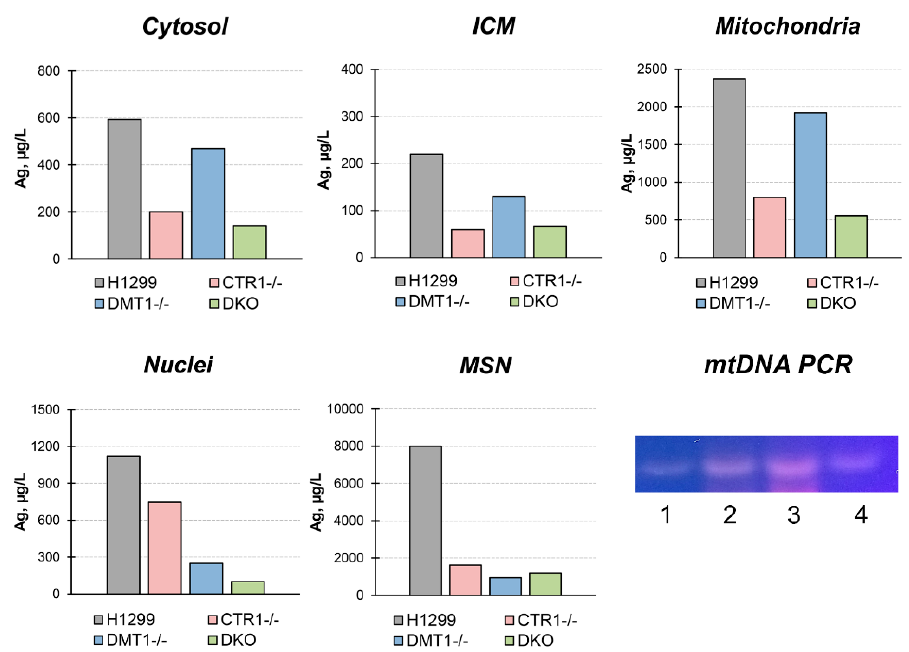
Figure 4. Silver distribution in H1299, CTR1 KO, DMT1 KO, and DKO cells. Y-axis: copper concentration (µg/L) in subcellular fractions. Gel: mtDNA-specific PCR products in subcellular fractions isolated from H1299 cells. 1, nuclei; 2, MSN; 3, mitochondria; 4, ICM. The samples contained 10 µ protein.